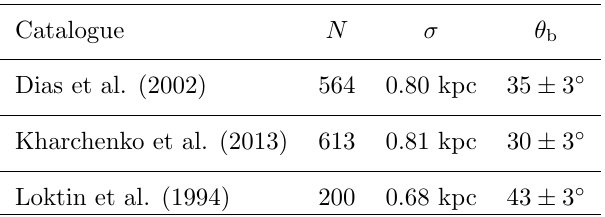
Fig. 2. The (cid:31) 2 functions calculated for different solar position angles (cid:18) b with respect to the major axis of the bar. The letters ”D”, ”Kh”, and ”L” denote the curves calculated for young open clusters from the catalogues by Dias et al. (2002), Kharchenko et al. (2013), and Loktin et al. (1994), respectively. The (cid:31) 2 curve calculated for the data by Loktin et al. (1994) is shown by the gray line, which is drawn for another range of the (cid:31) 2 values shown on the right vertical axis in gray. The three (cid:31) 2 curves reach their minima at (cid:18) b = 35 (cid:6) 3 ◦ (D), 30 (cid:6) 4 ◦ (Kh) and 43 (cid:6) 3 ◦ (L). Table1. Parameters of the